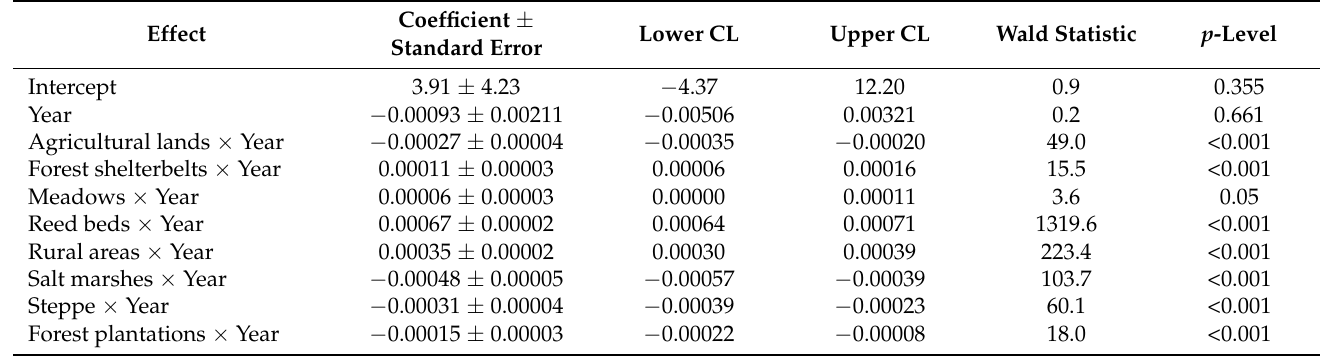
Table 2. Multiple generalized linear model of the effect of time and biotope type on bird community richness (the estimates for factors represent differences from the median value for the metacommunity as a